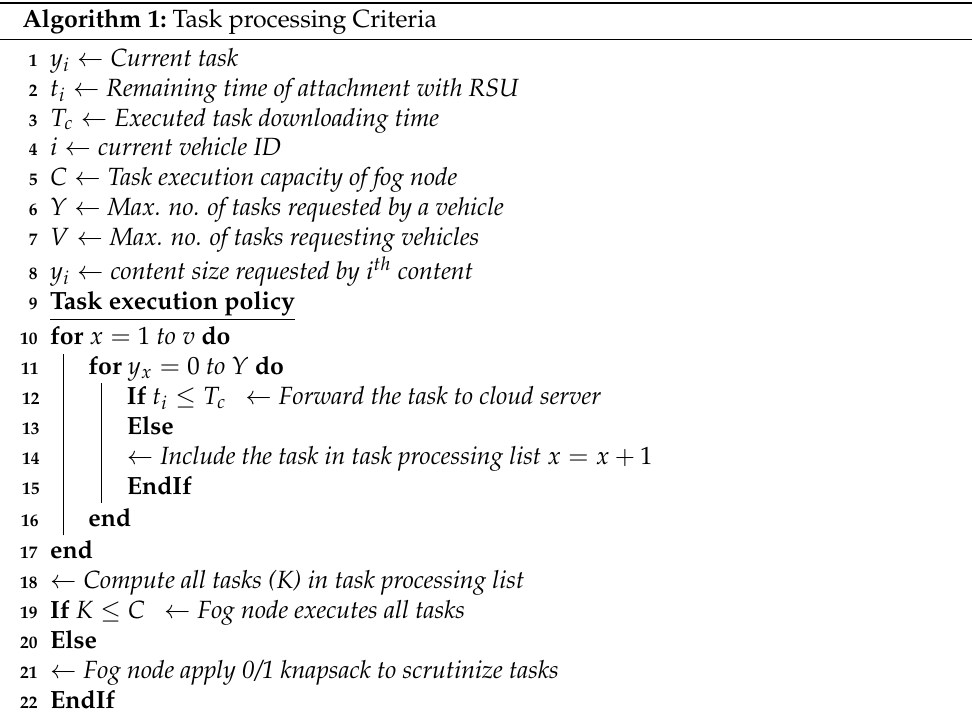
Algorithm 1: Task processing